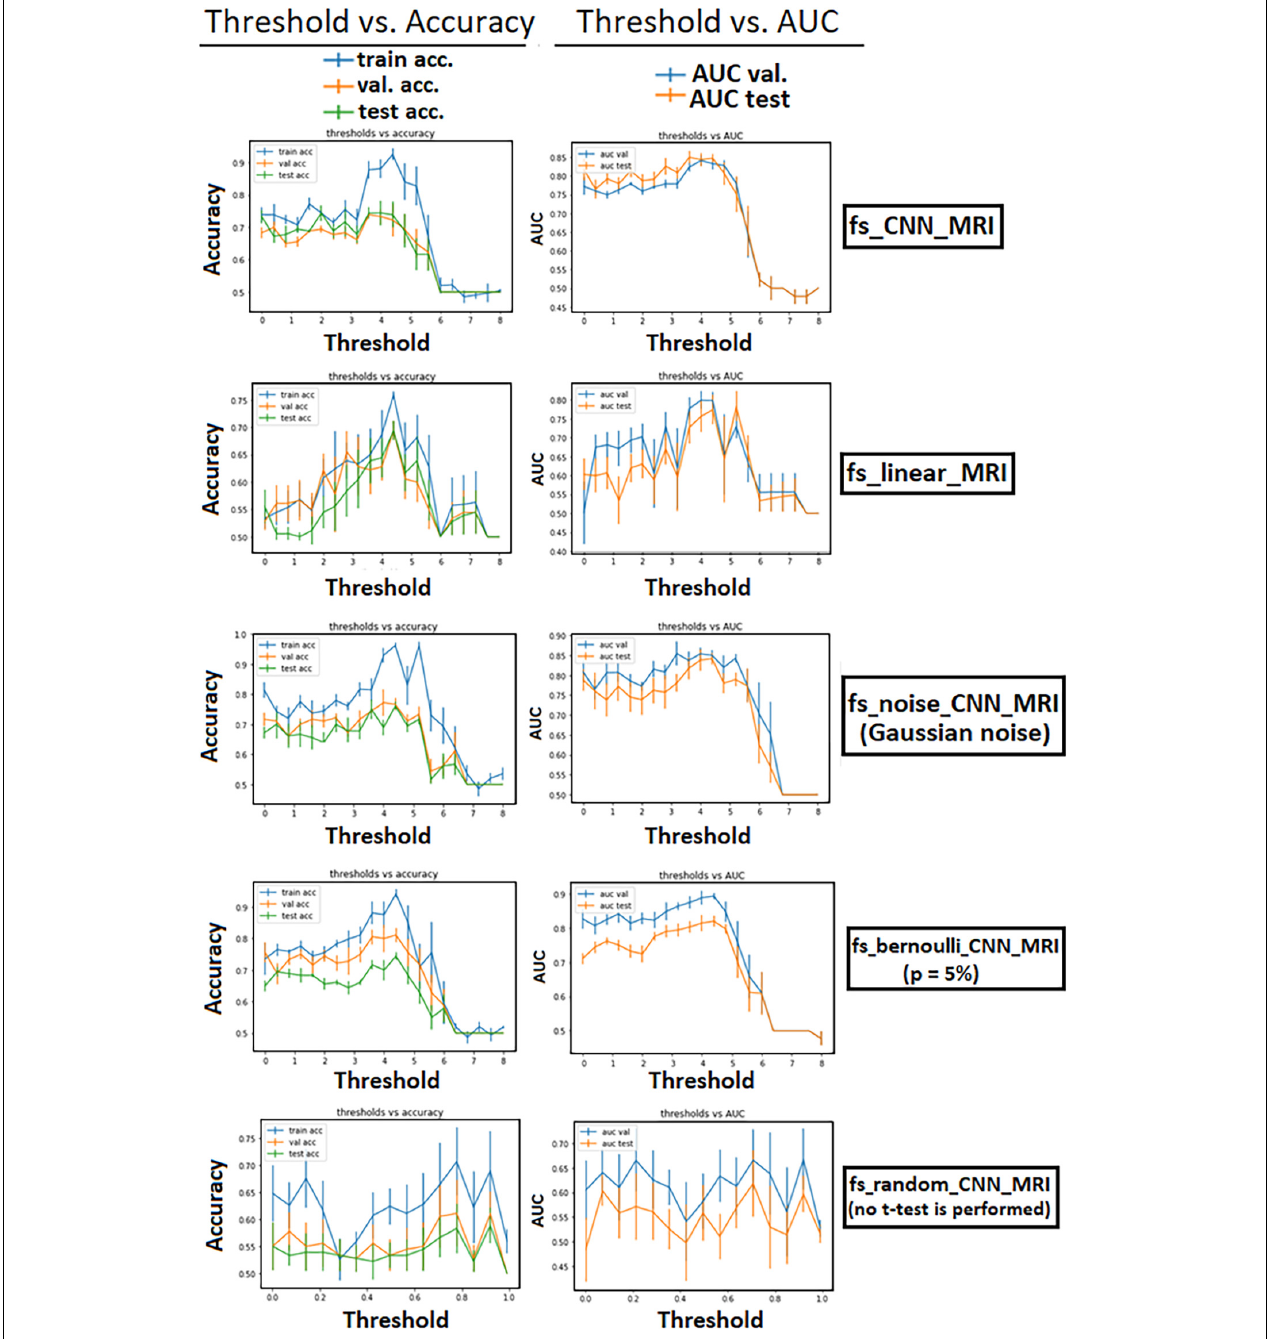
FIGURE 4 | Performance of the models as a function of the t -mask threshold. Error bars represent the standard deviation of the mean. For all t -masking models, the curves show how the metrics reach a peak value, improving the performance to the threshold increase until a final breakdown due to the loss of relevant voxels. The zero-point thresholds are equivalent measures of the norm_MRI model for fs_CNN_MRI and fs_noise_CNN_MRI. The bottom row shows the results in the case of “voxel-wise” dropout (with increasing p -value on the abscissa). There is evidence that the performance of fs_random_CNN_MRI rapidly decreases at increasing p